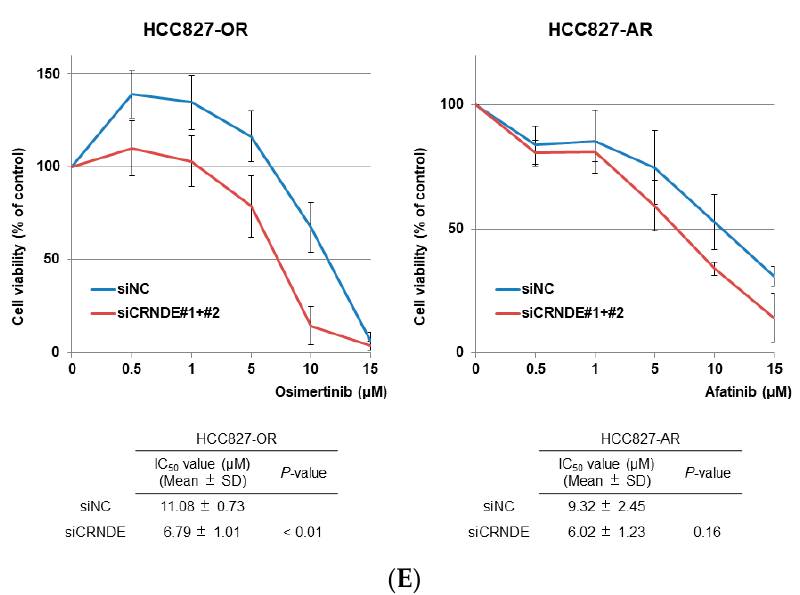
Figure 4. Knockdown of CRNDE induced apoptosis and recovered sensitivity to EGFR-TKIs in drug-resistant cells. ( A ) qRT- PCR showed that transfection of HCC827-OR cells with siRNA because CRNDE inhibited its expression. Fold change for the decrease in CRNDE relative expression. * p < 0.01. ( B ) Western blotting analysis showed constant protein expression of the AKT/mTOR signaling molecules and increased protein expression of the eIF4A3 downstream signaling molecules after knockdown of CRNDE in HCC827-OR cells. ( C ) Western blotting analysis showed overexpression of apoptosis-related proteins after treatment with osimertinib following knockdown of CRNDE in HCC827-OR cells. ( D ) Apoptosis induced by osimertinib at some concentrations after knockdown of CRNDE in HCC827-OR cells, as determined by annexin V- propidium iodide (PI) staining. ( E ) Dose-dependent sensitivity of EGFR-TKI-resistant cell lines to afatinib and osimertinib after knockdown of CRNDE by siRNA.